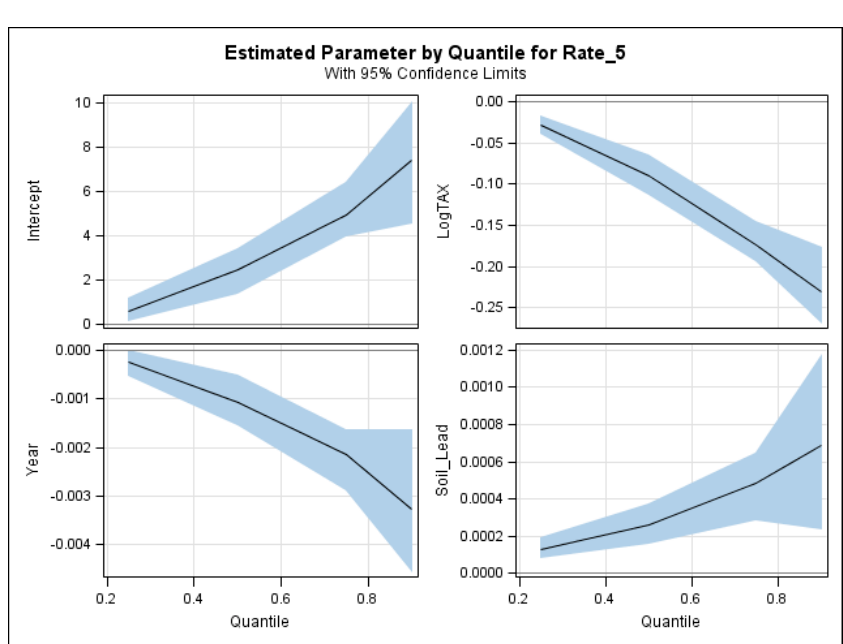
Figure 4. The model coefficient estimates of the global quantile regression models at different quantiles.